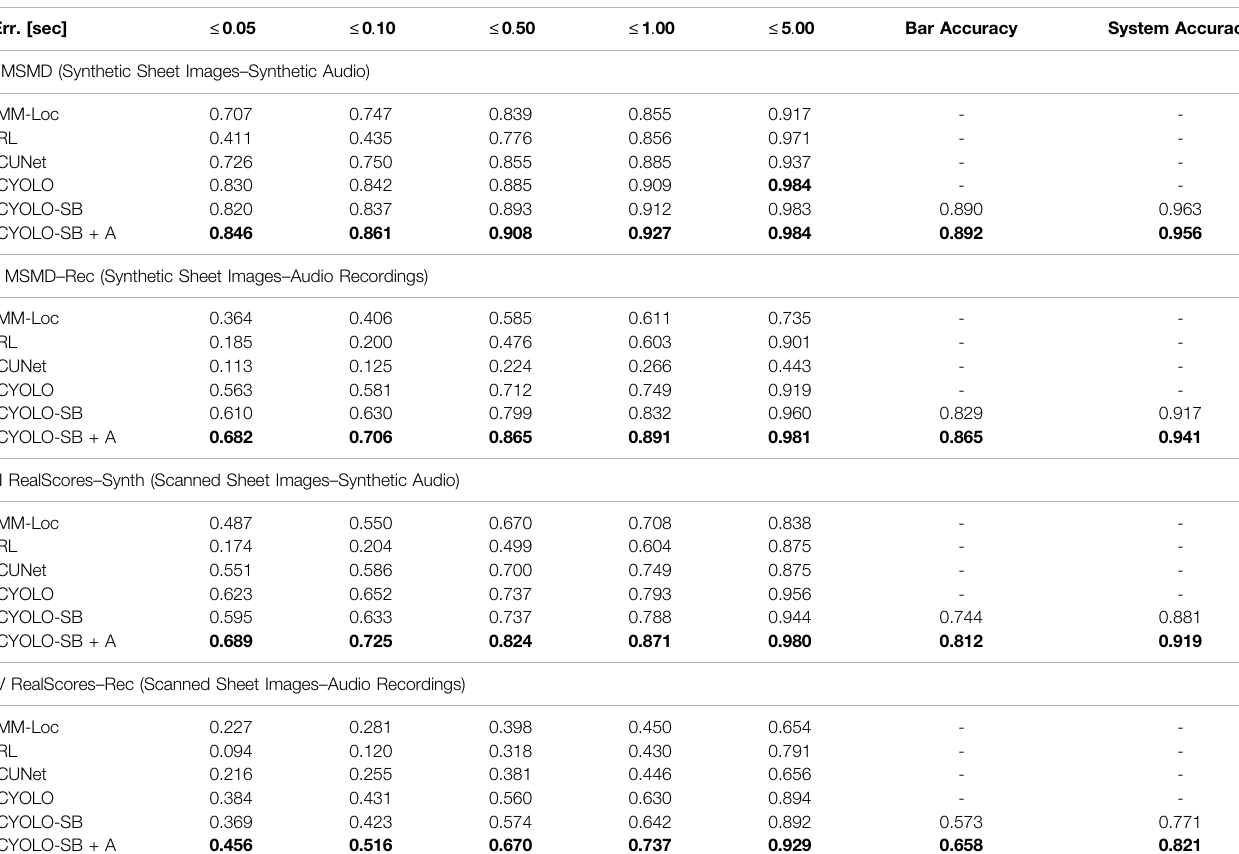
TABLE4| Comparisonofourproposedmethodstoseveralapproachesonthetestsetsasdescribedin Section5 .Wereporttheratiooftrackedonsetsbelowcertainerror thresholds from 0.05 to 5 s. The best result for each threshold is marked bold. Bar and system accuracies are only available for CYOLO-SB and CYOLO-SB + A. 6 Err.